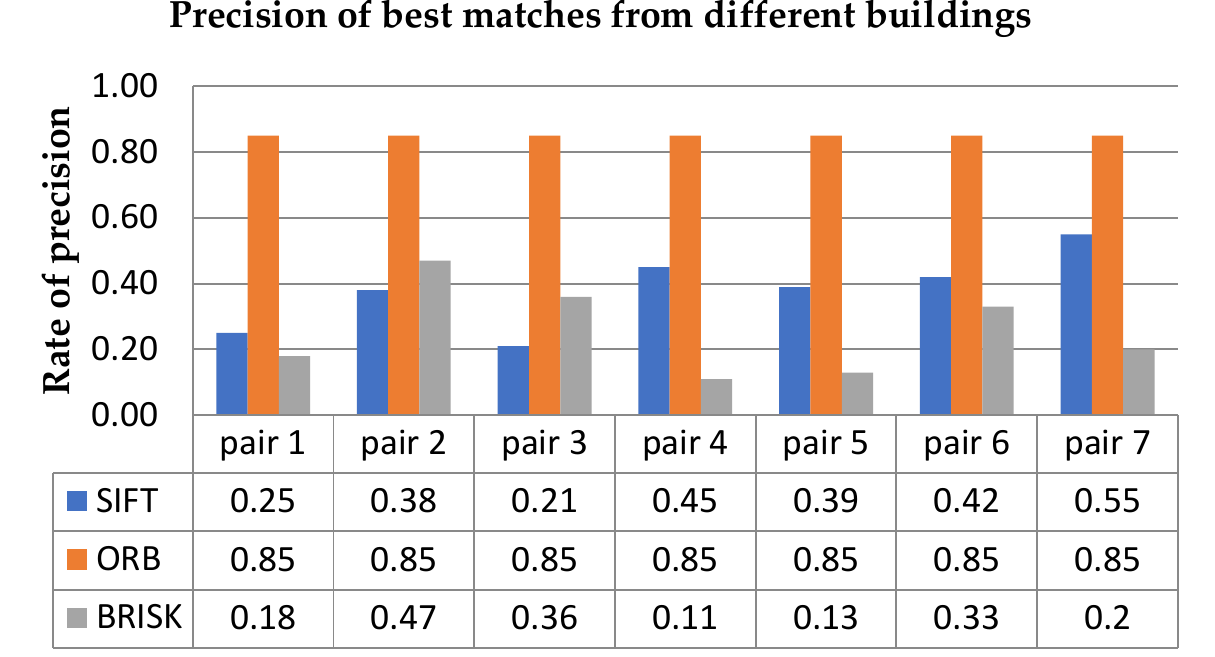
Figure 24. Rate of precision among pairs of different buildings.